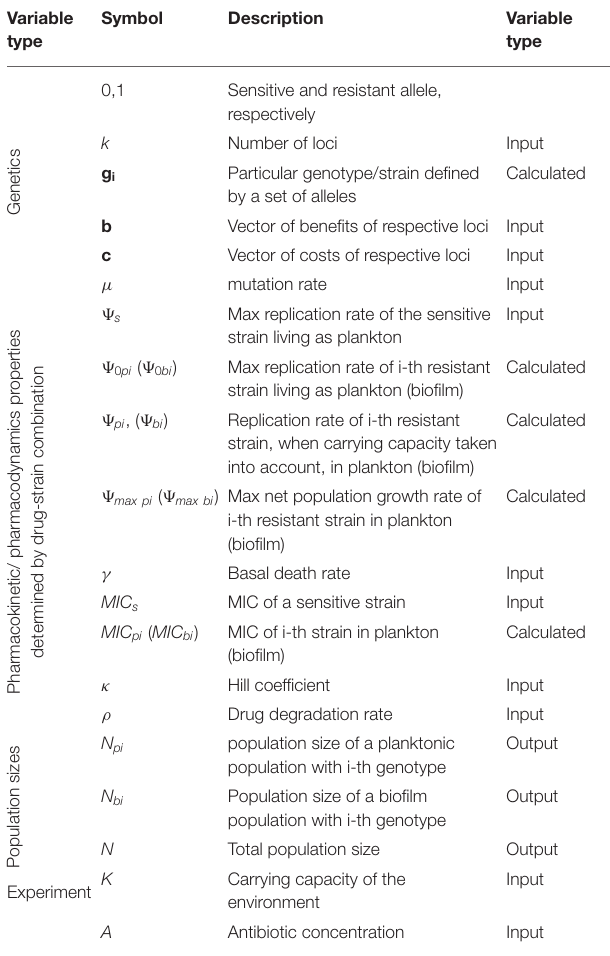
TABLE 1 | Symbols used in the model. Variable